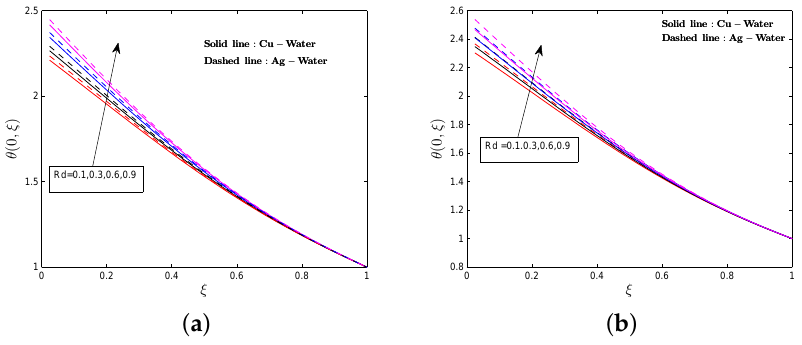
Figure 23. Surface temperature for various values of Rd . ( a ) vertical plate; ( b ) horizontal